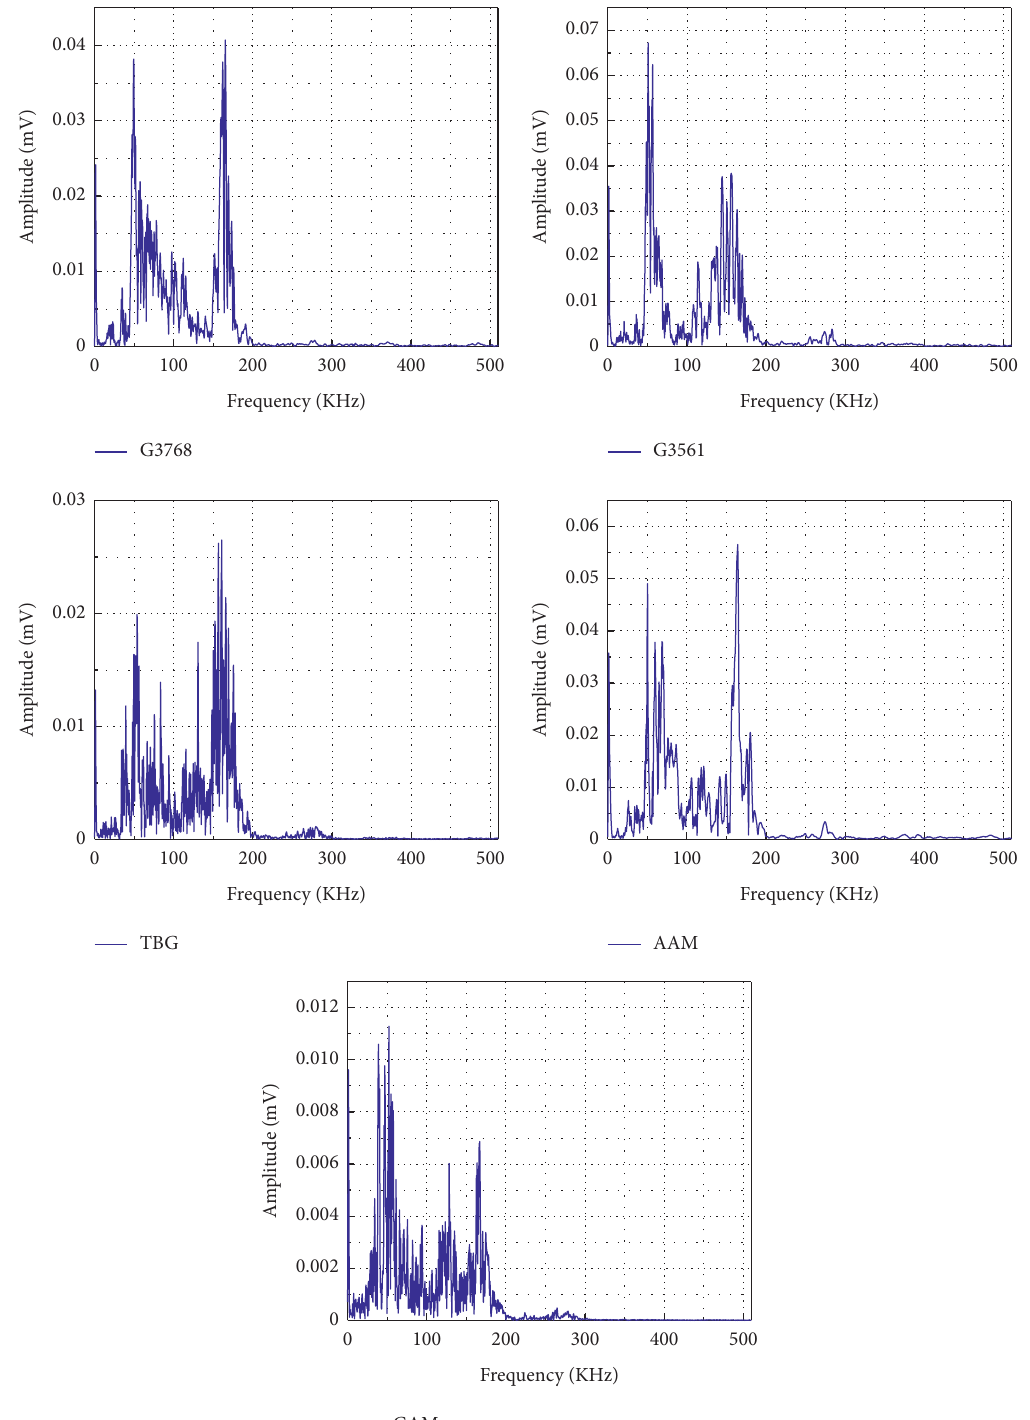
Figure 8: The spectrogram of measuring point M2 of rod-shaped